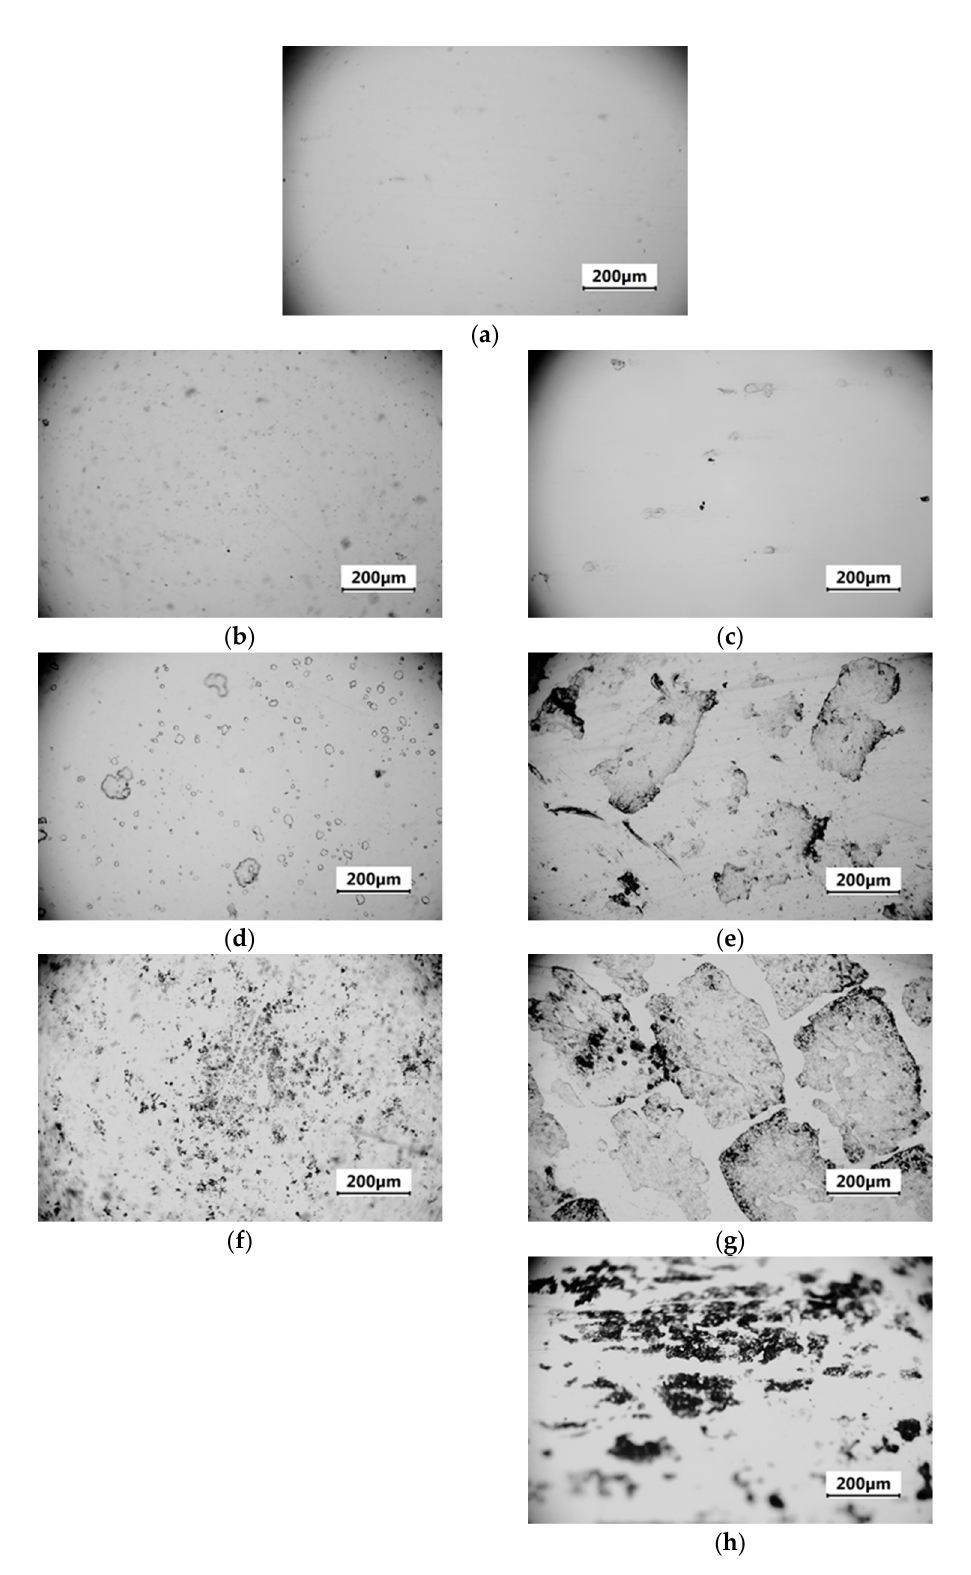
Figure 8. Micrographs of PLA samples before and after incubation in natural aqueous environments: ( a ) before degradation; ( b ) 3 months in pond water; ( c ) 3 months in seawater; ( d ) 6 months in pond water; ( e ) 6 months in seawater; ( f ) 12 months in pond water; ( g ) 12 months in seawater; ( h ) 16 months in seawater. Source: Own research.